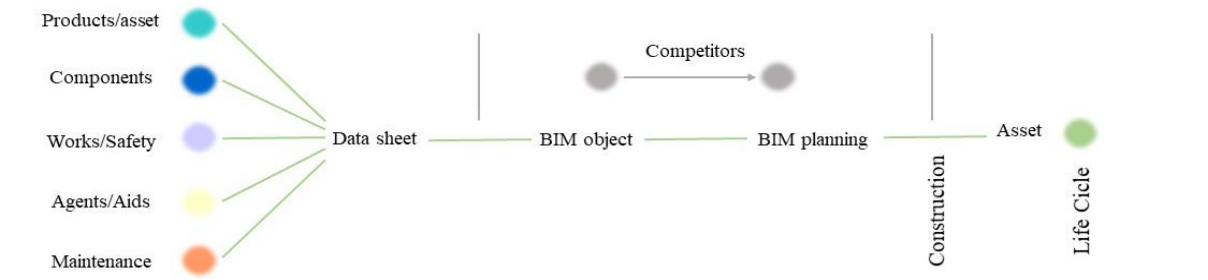
Figure 2. The INNOVance project is an example of an interoperable information exchange platform in the construction sector. It wants to promote the storage and structured extraction of information by the entire supply chain and in favour of the whole process, in order to allow this essential transition from graphic modeling to information management (Paravan et al.,